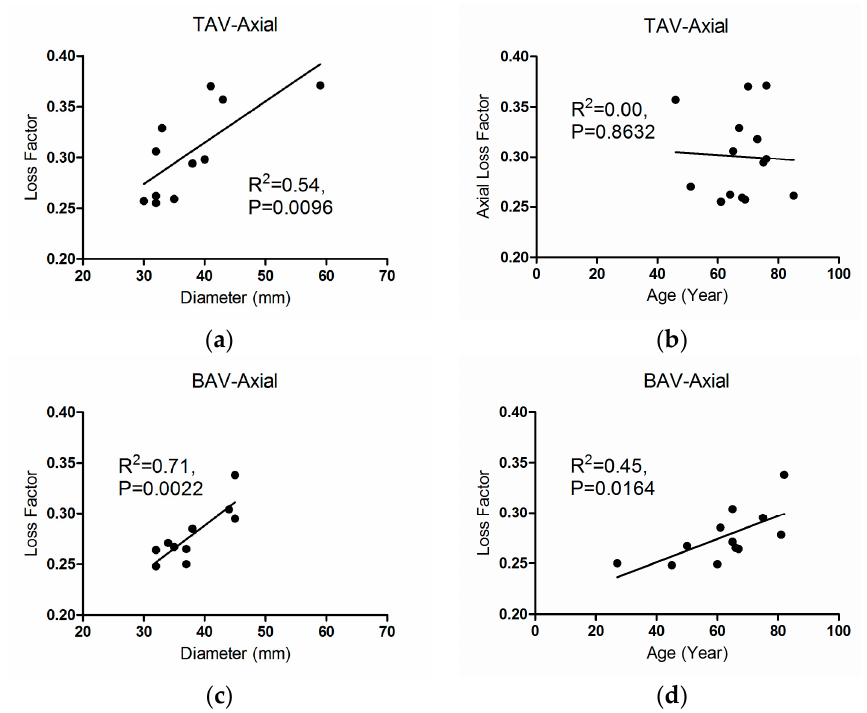
Figure 5. Average axial loss factor with respect to ( a ) aortic diameter for the TAV group; ( b ) age for the TAV group; ( c ) aortic diameter for the BAV group; and ( d ) age for the BAV group. The variations of collagen content and Col/Ela with aortic diameter are compared in Figure 6. Col/Ela increased significantly with aortic diameter for both TAV and BAV groups ( R 2 = 0.63, p =